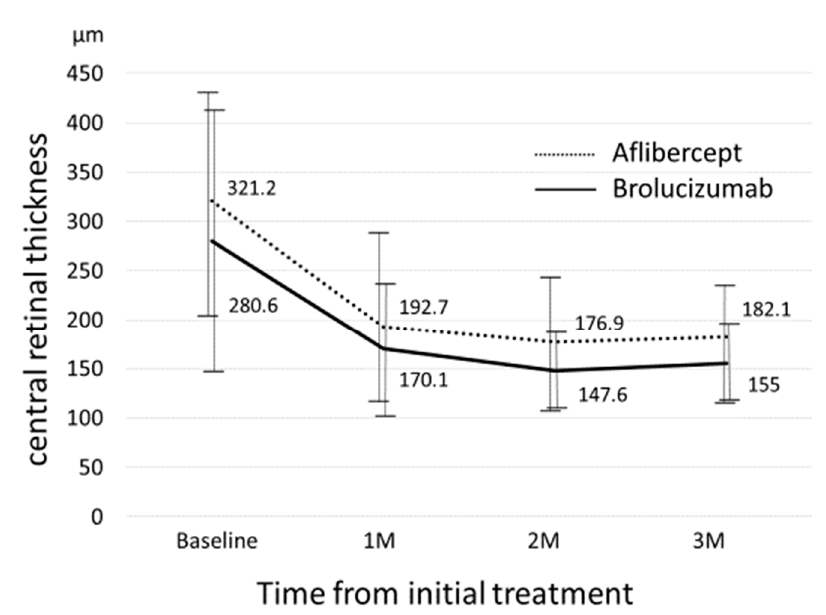
Figure 2. Changes in central retinal thickness between the brolucizumab-treated and aflibercept- treated groups.